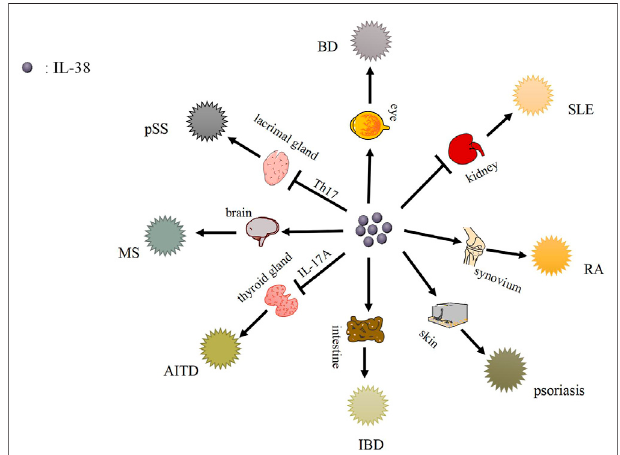
FIGURE 2 | The function role of IL-38 and its related autoimmune diseases. IL-38 is expressed in kidney, synovium, skin, intestinal tissues, etc., and causes related autoimmune diseases, such as SLE, RA, psoriasis,